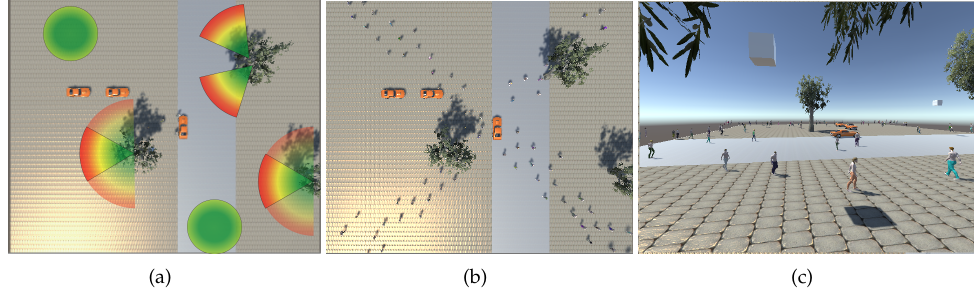
Figure 4. ( a ) Top view of the simulation environment including the camera positions. ( b ) Top view of the simulation environment including people. ( c ) Sample image from a PTZ